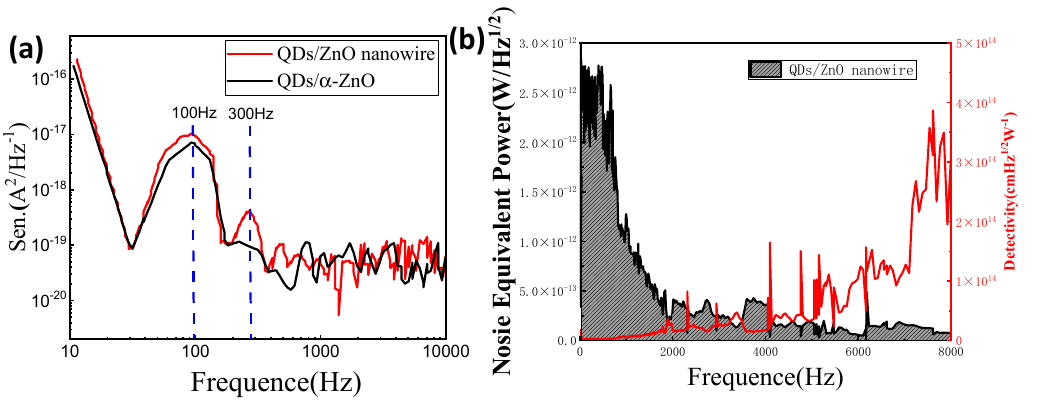
Figure 4. ( a , b ) The improved nanowire-PT’s noise equivalent power (NEP) and detectivity spectrum measured in relation to the gate frequency at 300 Hz under a dynamic detecting environment.